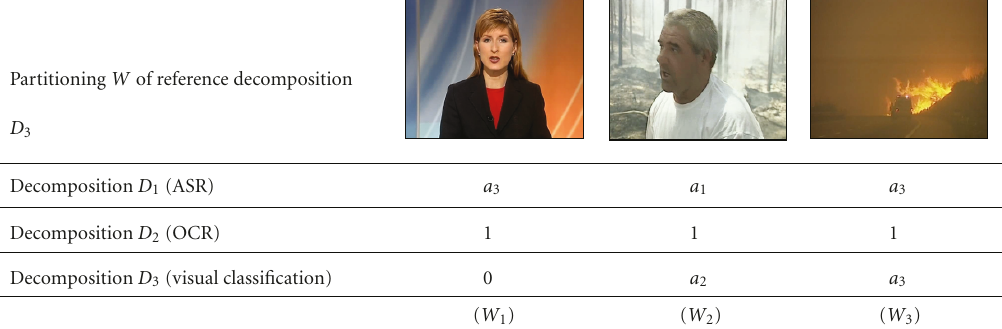
Figure 8: Example of function μ ( s j , s m ) defined for News video, where 0 < a 2 < a 1 < 1 and 0 < a 3 < 1, indicating the relevant semantic importance of the modality corresponding to decomposition D i for the analysis of segments of type W q . According to this example, when performing the multimodal analysis of a studio shot (column W 1 ), visual classification results are not taken into account, while ASR linguistic analysis results have lower importance than OCR linguistic analysis results; similar knowledge is encoded for shots of types W 2 and W 3 , as discussed in more detail in the experimental evaluation